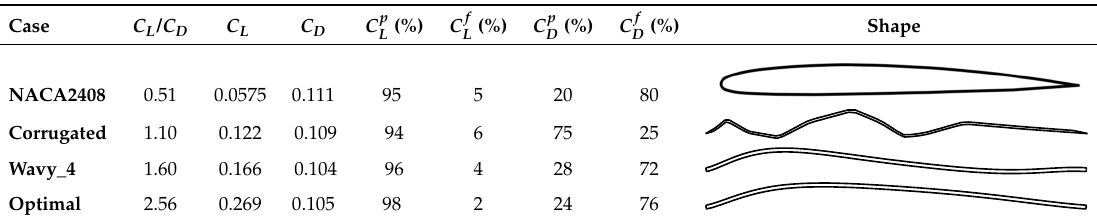
Table 4. Mean aerodynamic coefficients and its breakdown for the pressure and friction stress components of the initial airfoil geometry and optimal airfoil for aerodynamic efficiency maximization at Re = 10 3 and α = 0 ◦ .